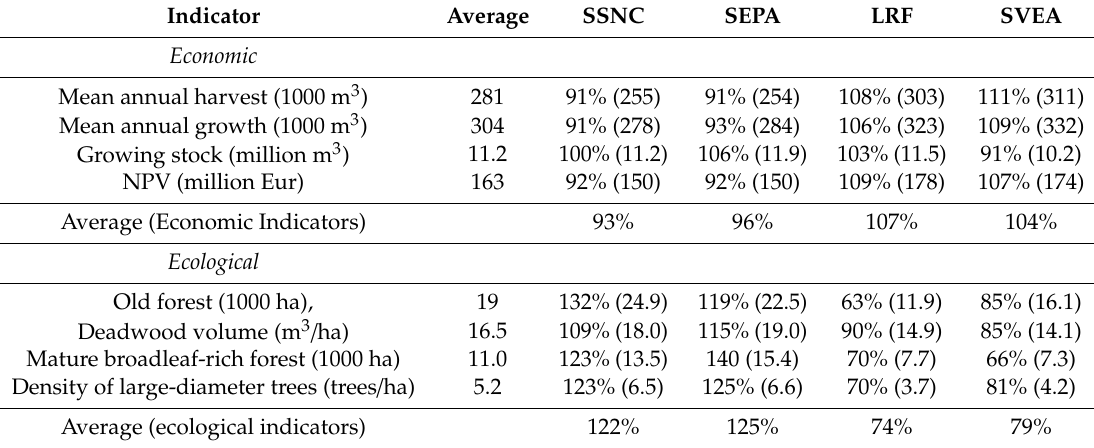
Table 6. Comparison of economic and ecological indicator levels (average over whole simulation period, except for NPV) for the four stakeholder scenarios. Column two is the average indicator value across all four scenarios, columns 3–6 give the percentage of each stakeholder scenario relative to the average (indicator value in parenthesis). Economic indicators exclude